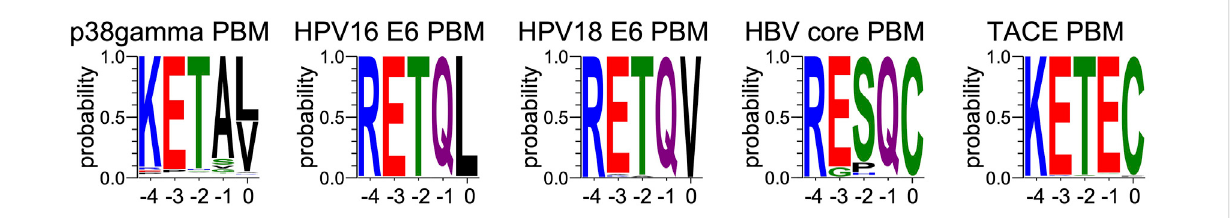
FIGURE 4 Comparison of sequence conservations of PBMs of p38 γ , HPV16 E6, HPV18 E6, HBc and TACE. For each extension, all UniprotKB sequences of the correspondingproteinwerealigned. The result isdisplayedusing alogorepresentation (Crooks etal.,2004),wheretheheight ofeach residueone-letter code translates to its conservation at the corresponding position in the sequence alignment. Amino acids are coloured according to their chemical properties: polar amino acids (G,S,T,Y,C,Q,N) are green, basic (K,R,H) blue, acidic (D,E) red and hydrophobic (A,V,L,I,P,W,F,M) amino acids are black. The positions of the PBM are indicated above the